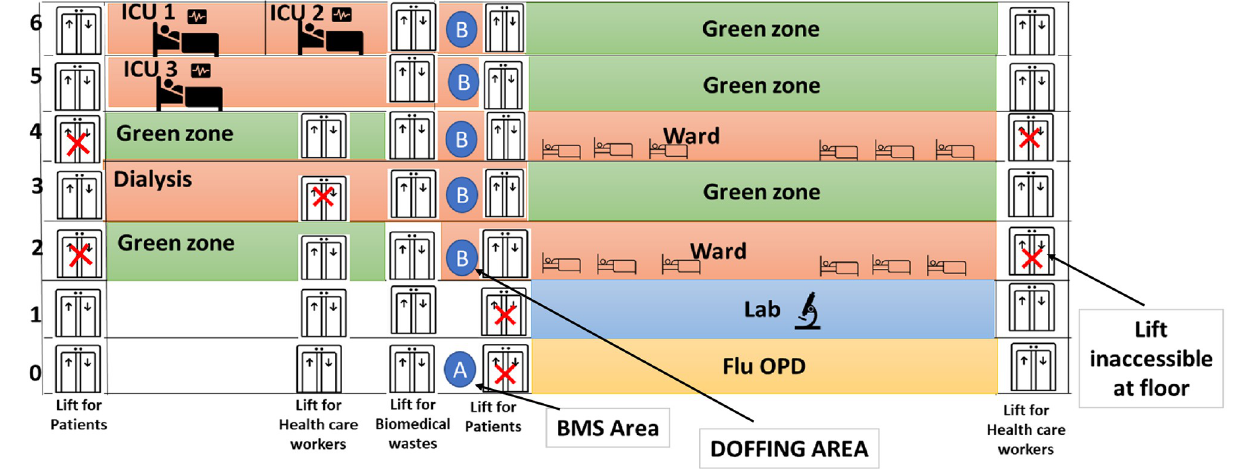
Fig 2. Floor wise plan of the dedicated COVID-19 treatment centre into different zones for ease of IPC implementation.